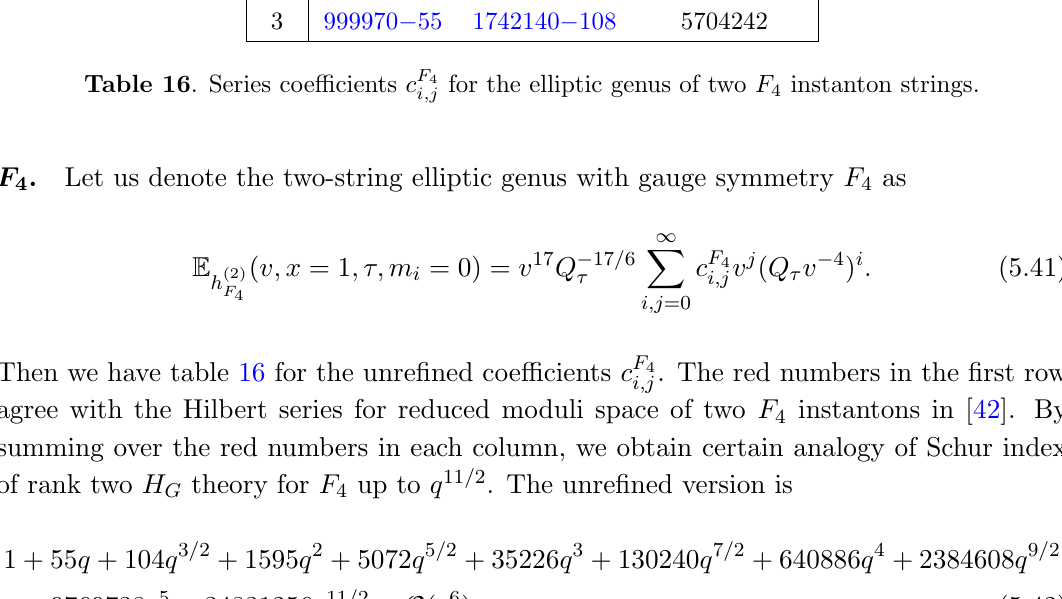
Table 16 . Series coe(cid:14)cients c F 4